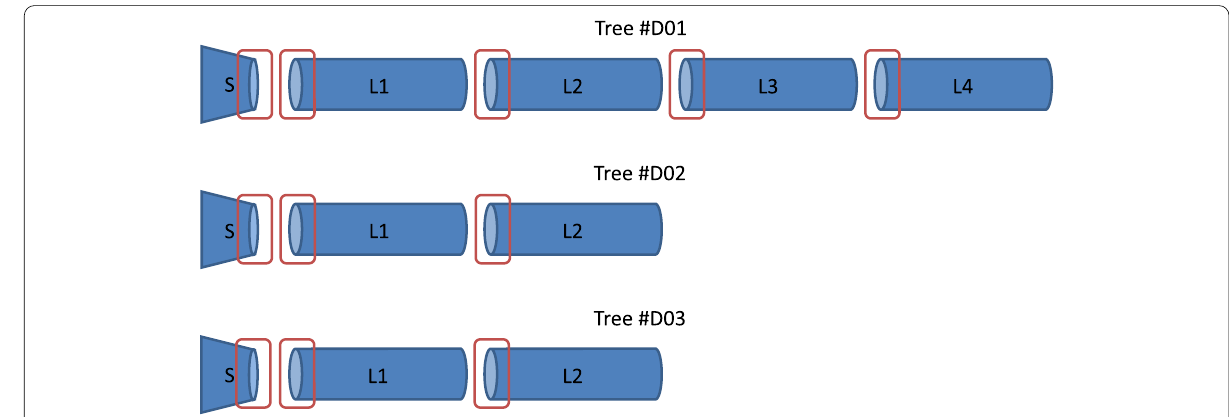
Fig. 14 Diagram for image sampling. Cross‑section images (of the stumps or large log ends) were taken in the areas circled in